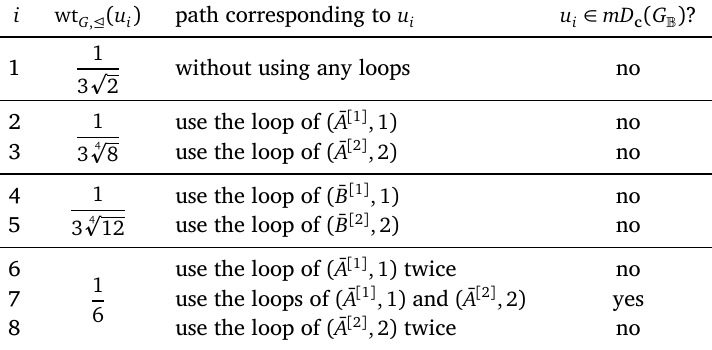
Table 4: First eight paths (sorted by their image under wt G , ⊴ ) in the product of M ′ ( G ) and M B h , w and whether the corresponding candidate u i is in mD c